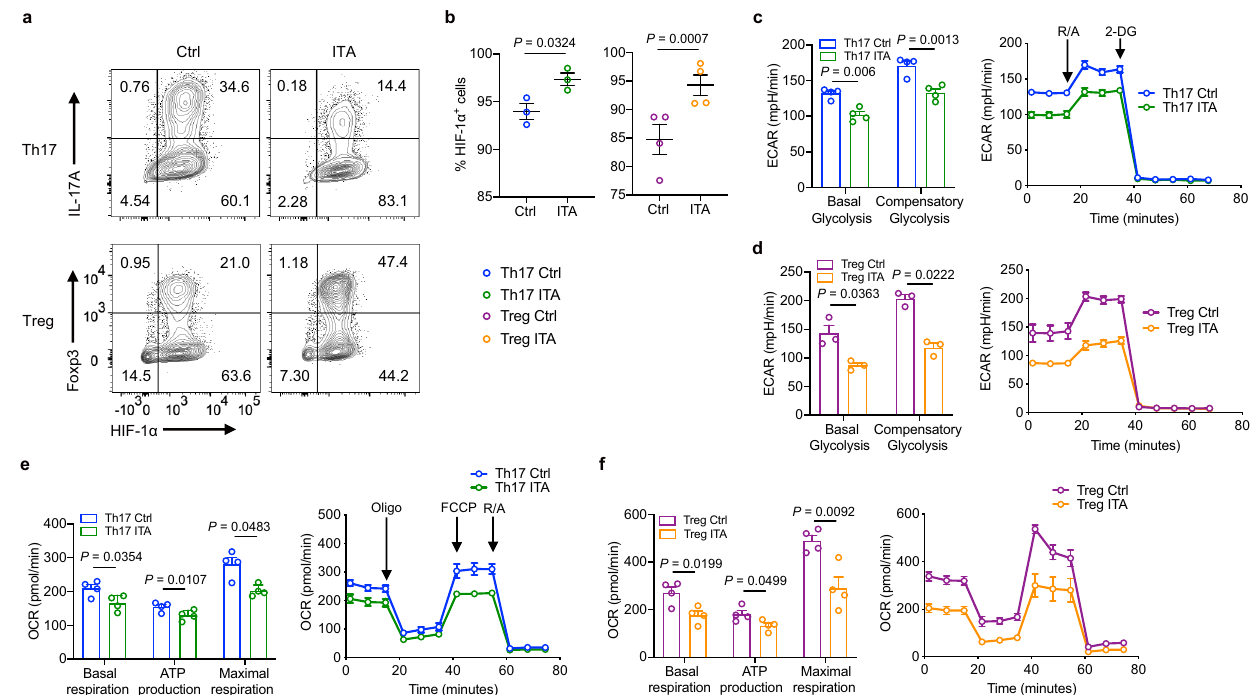
Fig. 4 | Itaconate inhibits glycolysis without suppressing HIF-1 α . Intracellular HIF-1 α expression in Th17- and Treg-polarizing T cells with or without itaconate (ITA) ( a ), percentage of HIF-1 α + cells under each growth condition ( b ) (Th17, n =3; Treg, n =4). Extracellular acidi fi cation rate (ECAR) of Th17- ( c ) and Treg-polarizing T cells ( d ) with or without ITA measured using glycolytic rate assay (Th17, n =4;